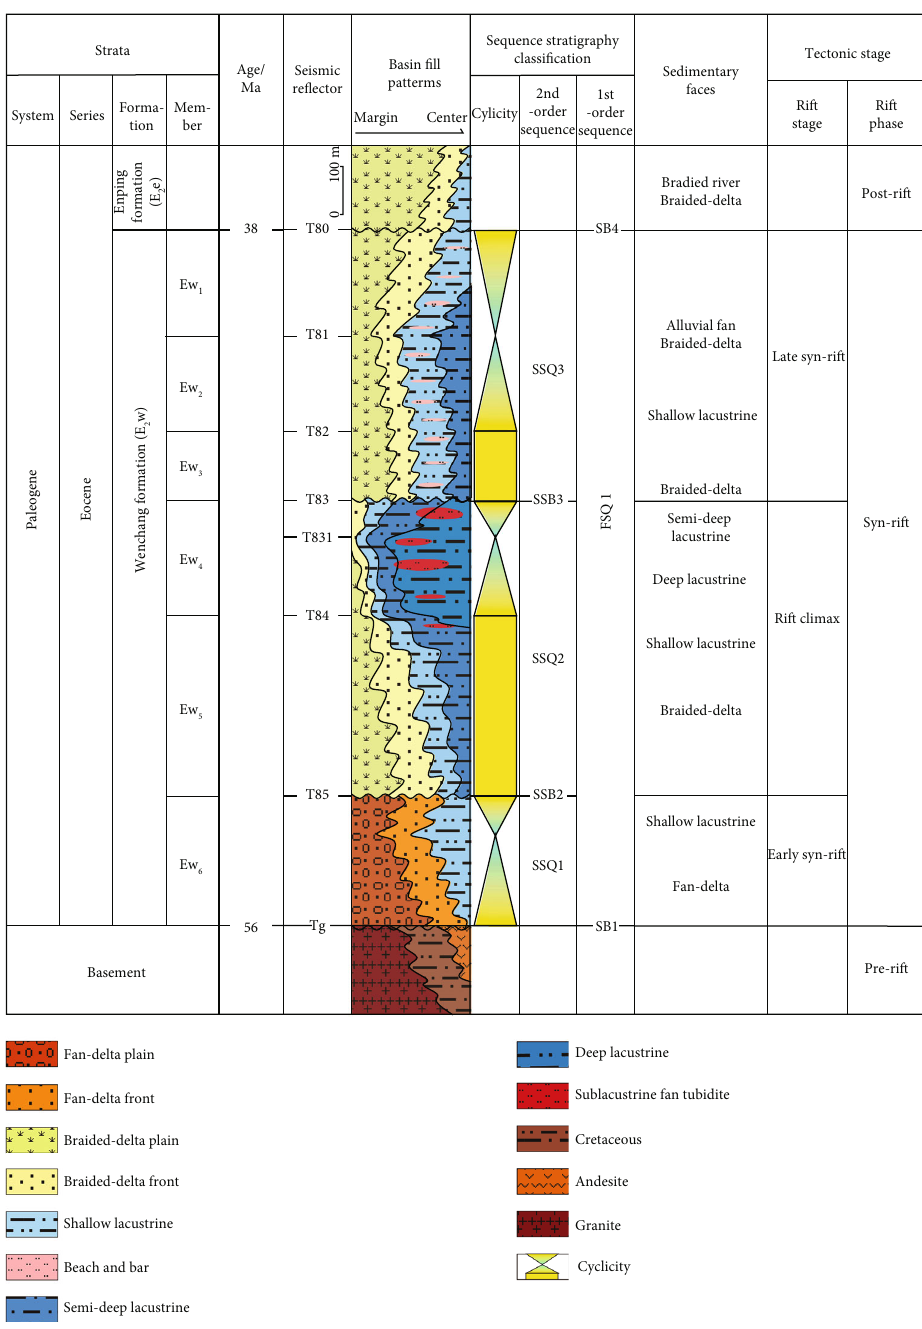
Figure 2: Sequence stratigraphy characteristics of the Eocene Wenchang Formation in Pearl River Mouth Basin (modi fi ed from